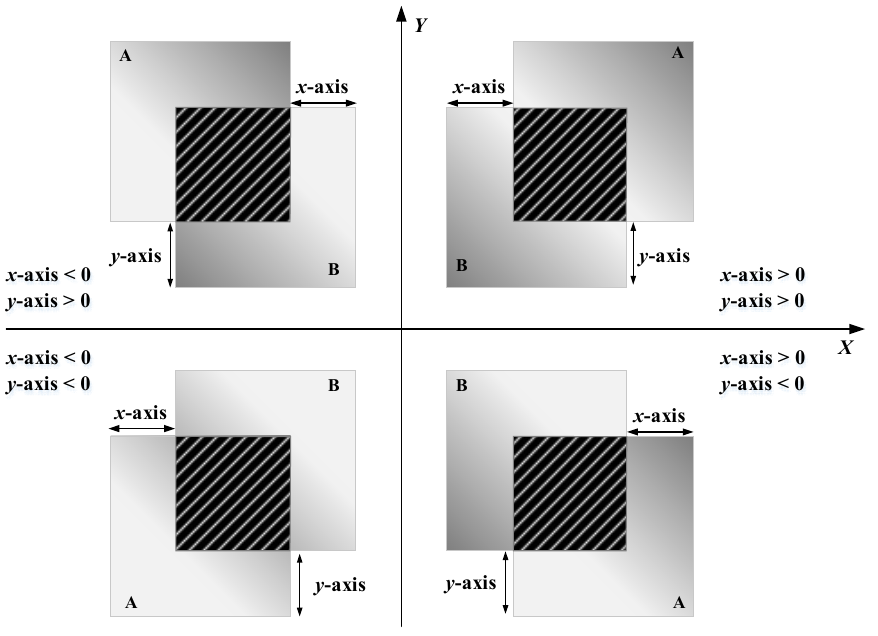
Figure 3. The relative position of the images.